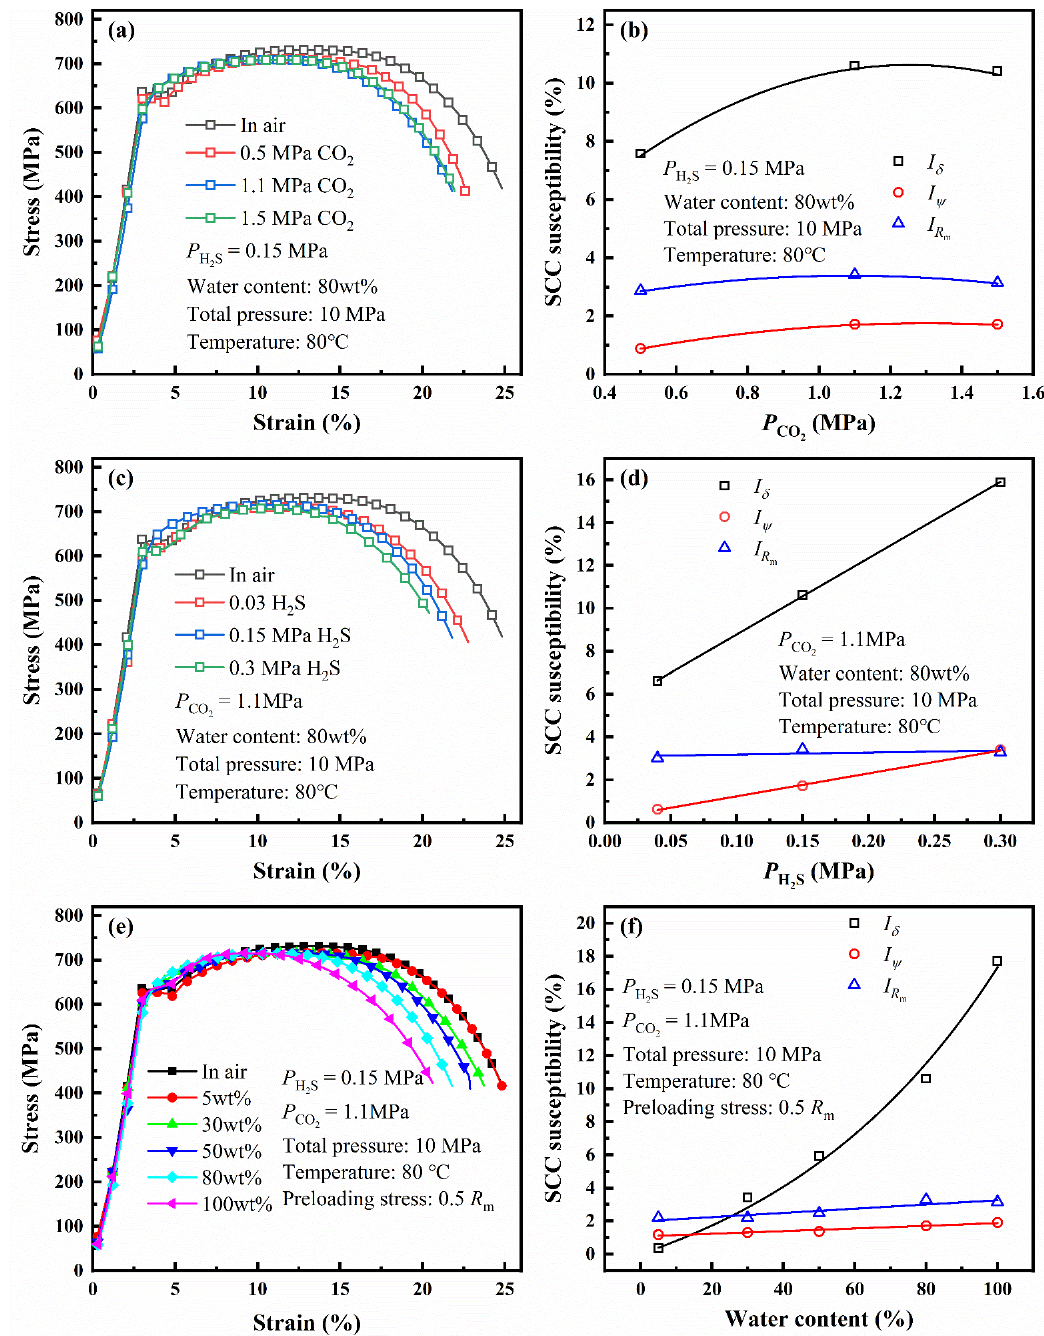
Figure 6. Stress–strain curves and SCC susceptibility of L80 steel under different partial pressure of CO 2 ( a , b ), different partial pressure of H 2 S ( c , d ) and water content ( e , f ).